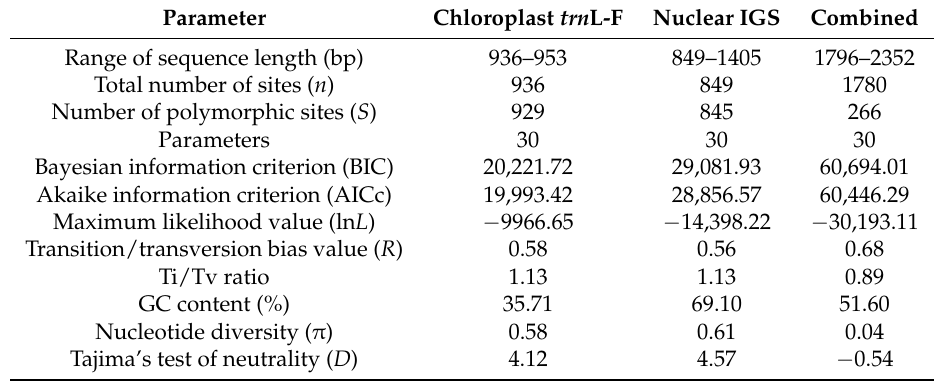
Table 3. Comparison of phylogenetic information for the tidal swamp rice genome from two datasets 1